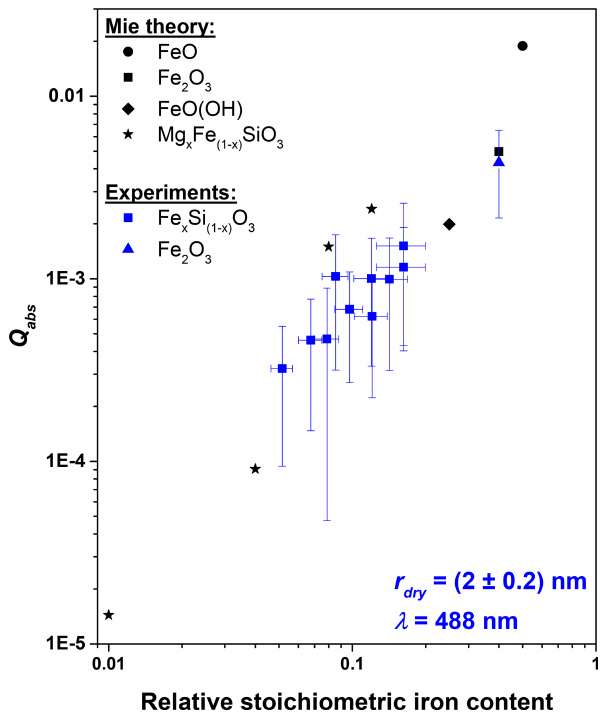
Figure 4. Absorption efficiencies for r dry = 2nm particles at λ = 488nm of various particle materials as a function of the relative stoichiometric iron content. Blue squares and the triangle repre- sent experimental results for Fe x Si 1 − x O 3 (0 <x< 1) and Fe 2 O 3 par- ticles, respectively. The black circle, square, diamond, and stars represent Mie theory calculations for FeO, Fe 2 O 3 , FeO(OH), and Mg x Fe 1 − x SiO 3 particles using refractive indices from literature (see text).